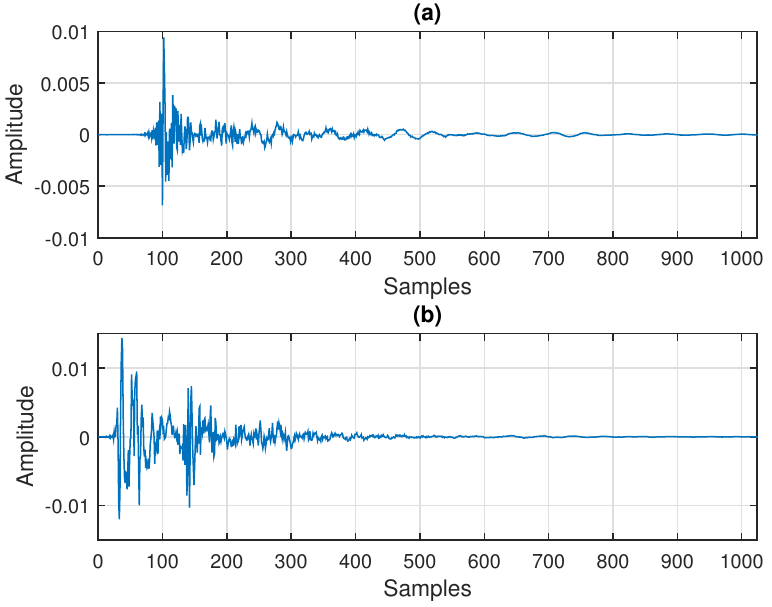
Figure 4. Impulse responses used in the second set of simulations from Section 6, with L = 1024 and M = 2: ( a ) right acoustic echo path and ( b ) left acoustic echo path.